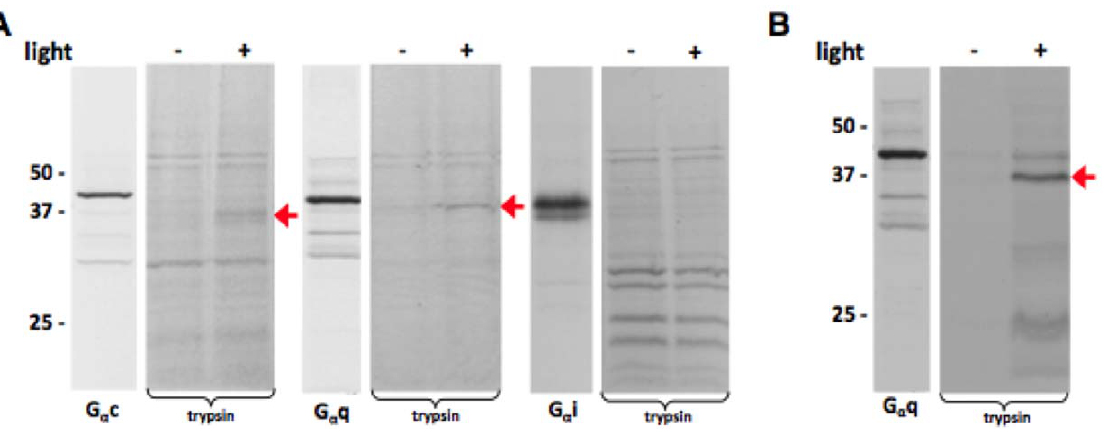
Figure 5. Light-dependent activation of coral G proteins by acropsins. In vitro translated G a subunits were reconstituted with membranes of acropsin-expressing HEK293t cells as described in Materials and Methods. The proteins were exposed to light or kept dark and then incubated with trypsin for 60 min. The resulting patterns of 35 Met-labeled products were analyzed by SDS-PAGE. (A) Reconstitution of acropsin 1 with coral Gc, Gq, and Gi; GTP c S was present in all reactions. Red arrows indicate stabilized forms of Gc ( , 36 kDa) and Gq ( , 37 kDa) in light. (B) Reconstitution of acropsin 3 with coral Gq. The 37 kDa product, observed only in the presence of light, is indicated by the red arrow.